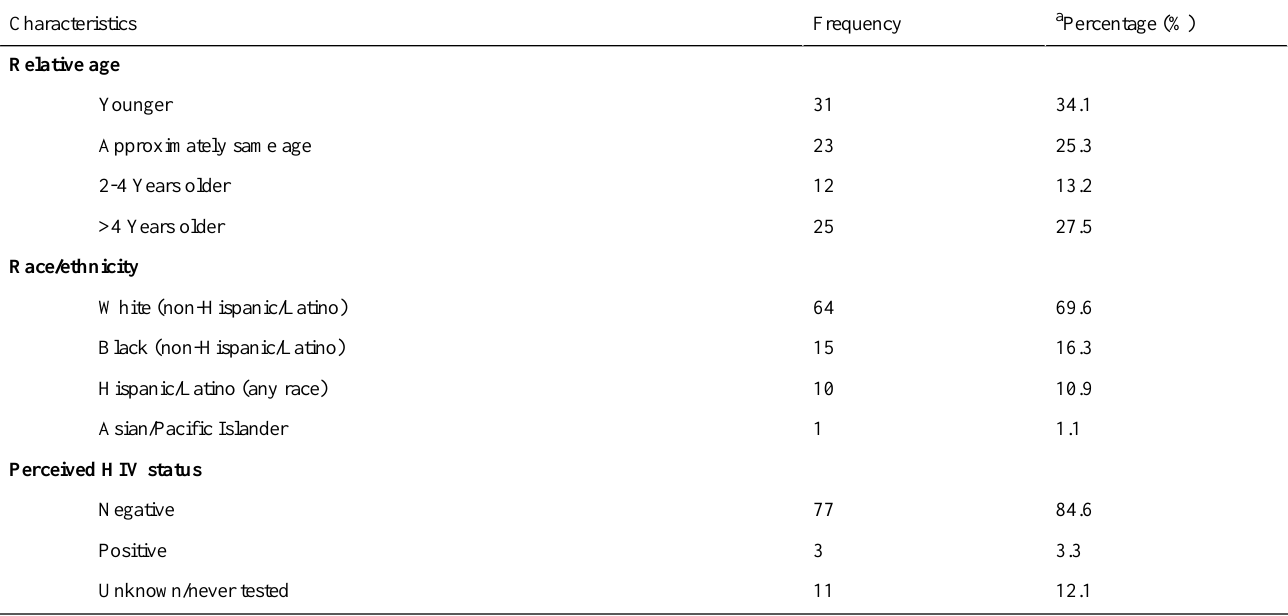
Table 4. App-met partner